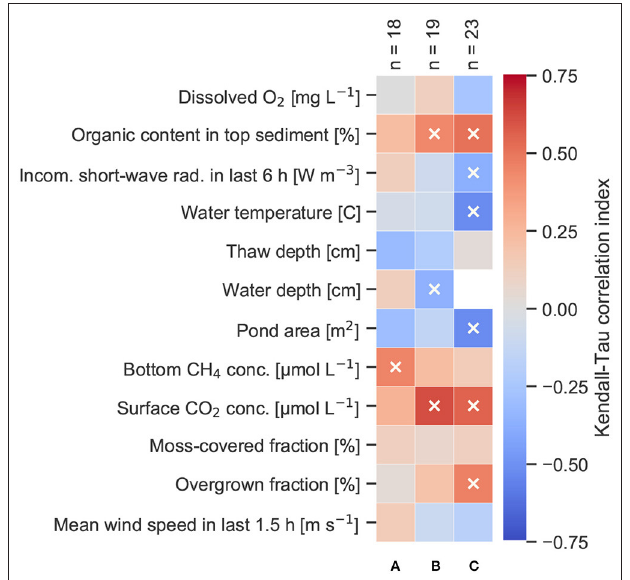
FIGURE 6 | Kendall-Tau correlation index of different variables with surface methane concentrations in (A) ice-wedge ponds, (B) polygonal-center ponds, (C) merged polygonal ponds. Significant correlations ( p < 0.05) are marked by a white cross. Number of measurements per pond type ( n ) is indicated at the top of each column.